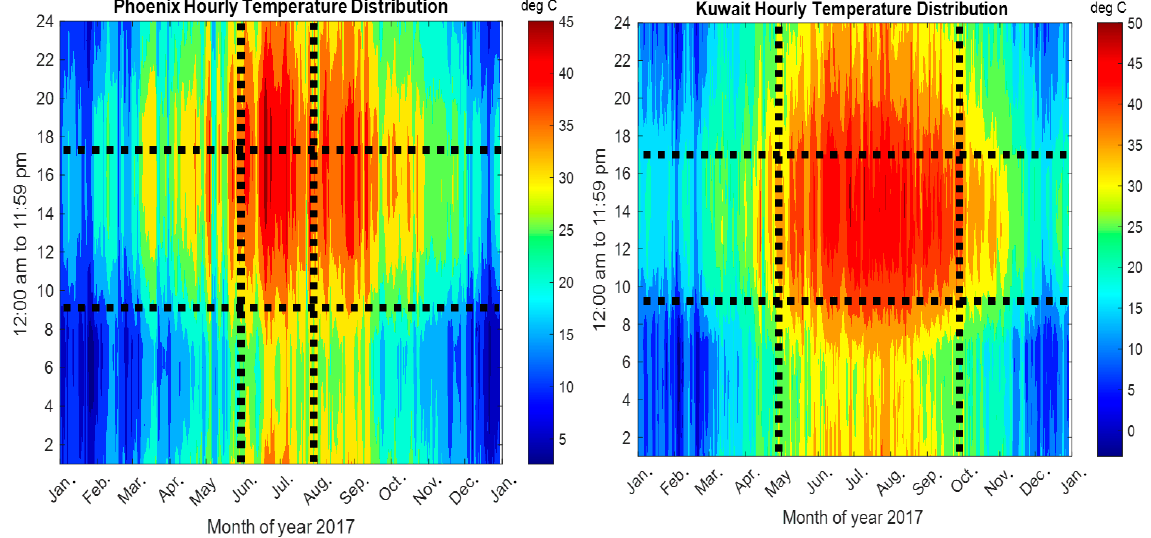
Figure 2. Hourly temperature distribution for Phoenix, Arizona, USA and Kuwait in 2017 [124].